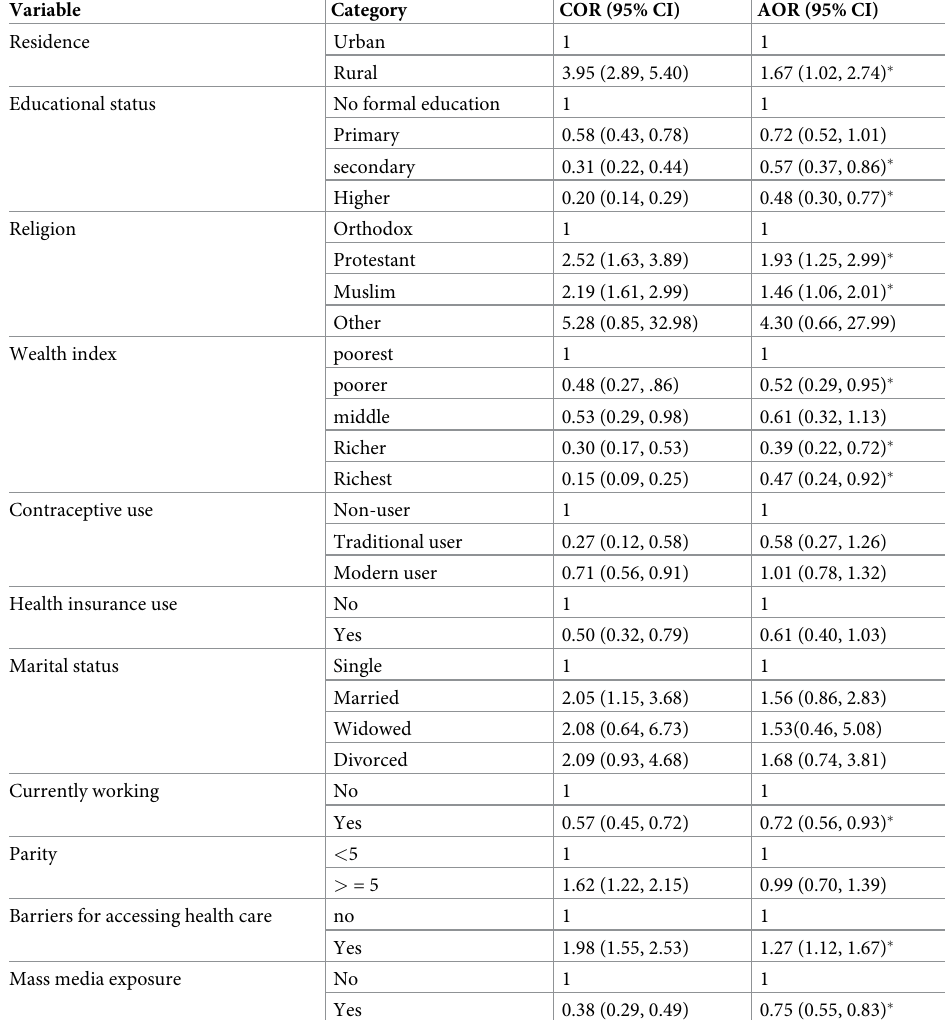
Table 4. Associated factors of incomplete utilization of maternal continuum of care among reproductive aged women in Ethiopia,